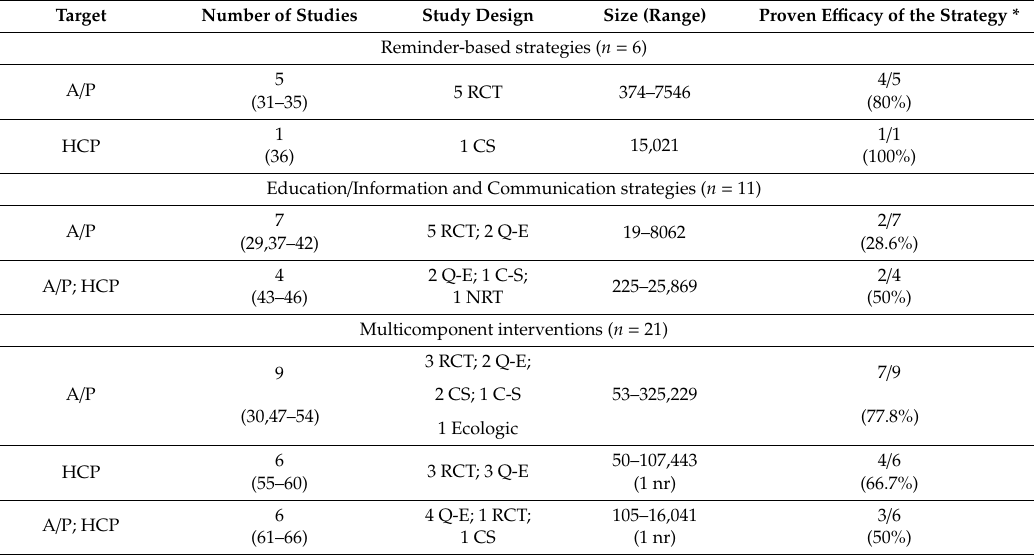
Table 1. Results